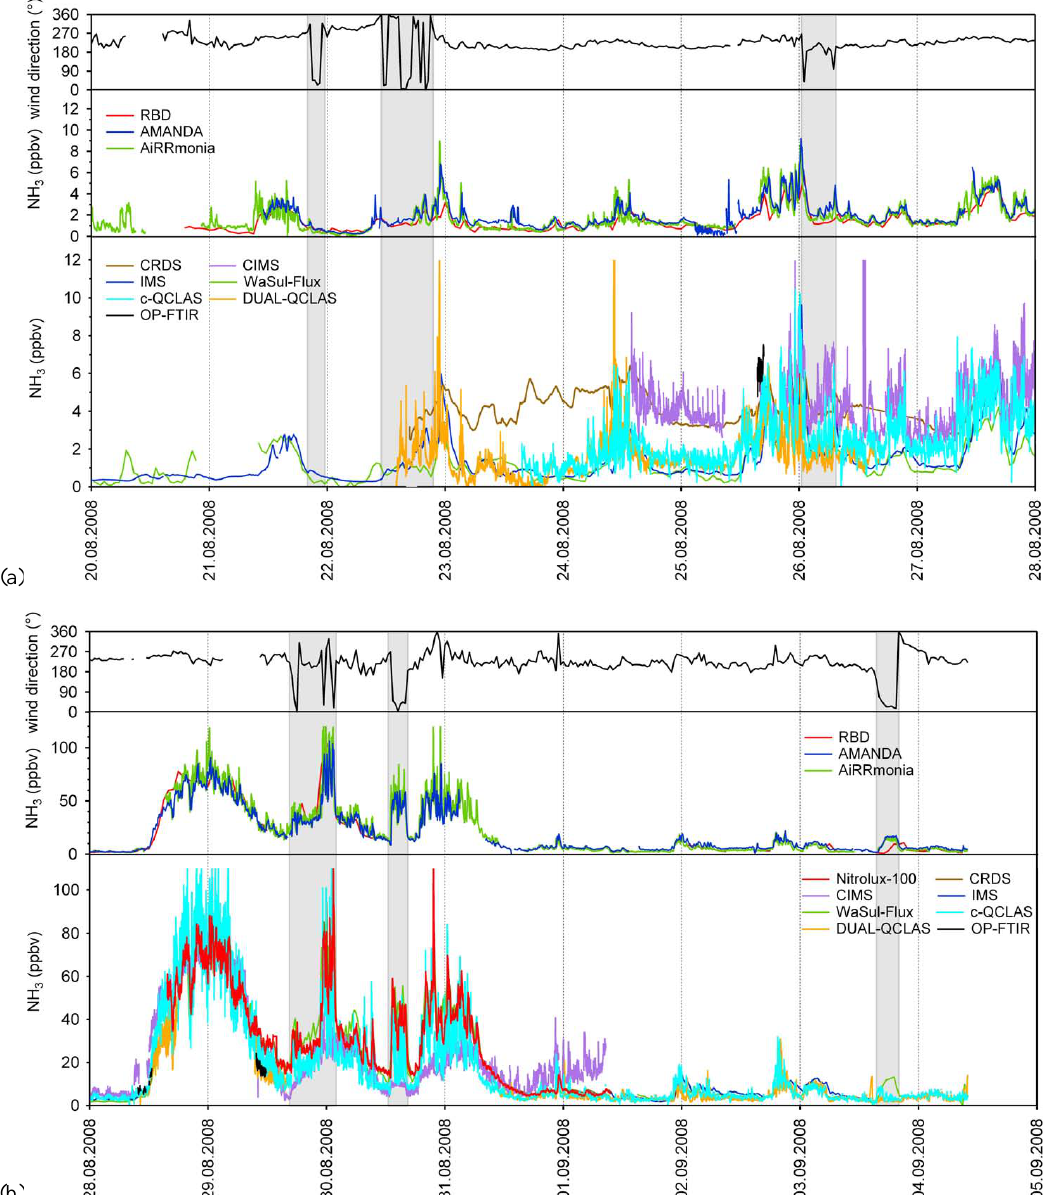
Fig. 3. Times series of NH 3 for all instruments ( z =1.1m) with occurring wind direction for the data (a) before fertilisation and (b) after fertilisation on 28 August 2008. The shaded areas indicate periods during which the wind came from the N field. RBD (red), AMANDA (blue), AiRRmonia (green), Nitrolux-100 (red), CRDS (brown), CIMS (purple), IMS (blue), WaSul-Flux (green), c-QCLAS (cyan) , DUAL- QCLAS (orange), OP-FTIR